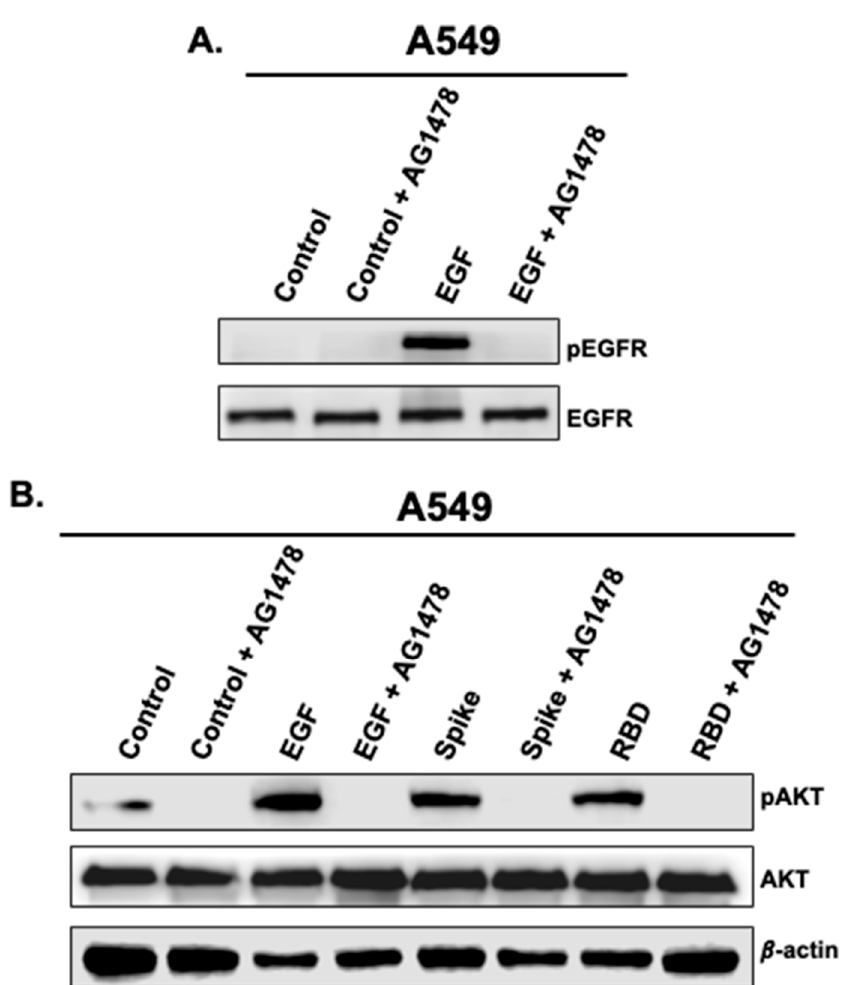
Figure 3. Blockade of EGFR inhibits SARS-CoV-2 spike 1-mediated activation of AKT in A549 cells. A549 were first pre-treated with AG1478 (10 µM) for 15 min prior to treatment with EGF ( A , B ), full-length spike 1 protein or spike RBD protein ( B ) as described in Figure 1. Whole cell extracts were resolved on SDS-PAGE and protein levels were determined by western blot.